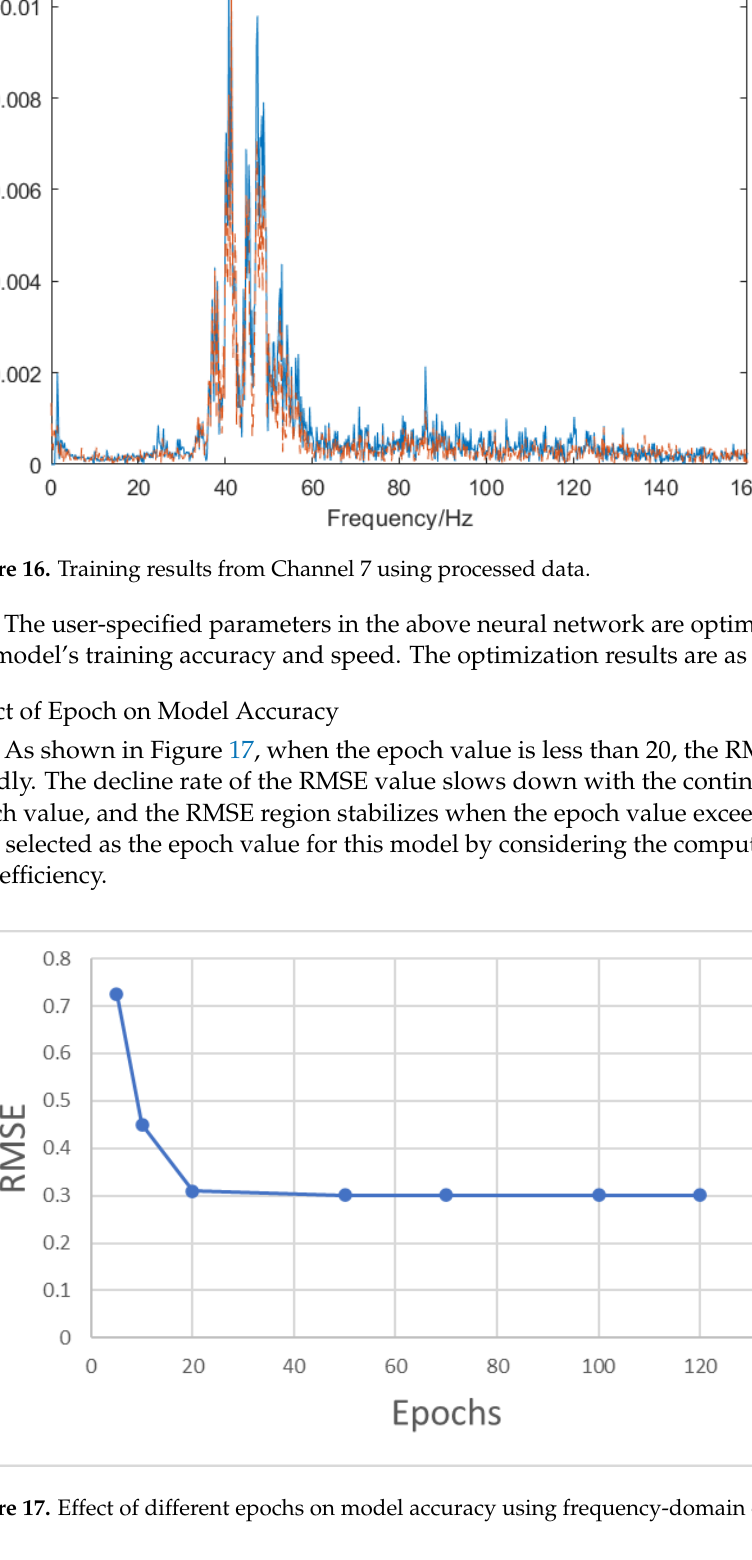
Figure 18. Effect of different batch sizes on model accuracy using frequency-domain data.